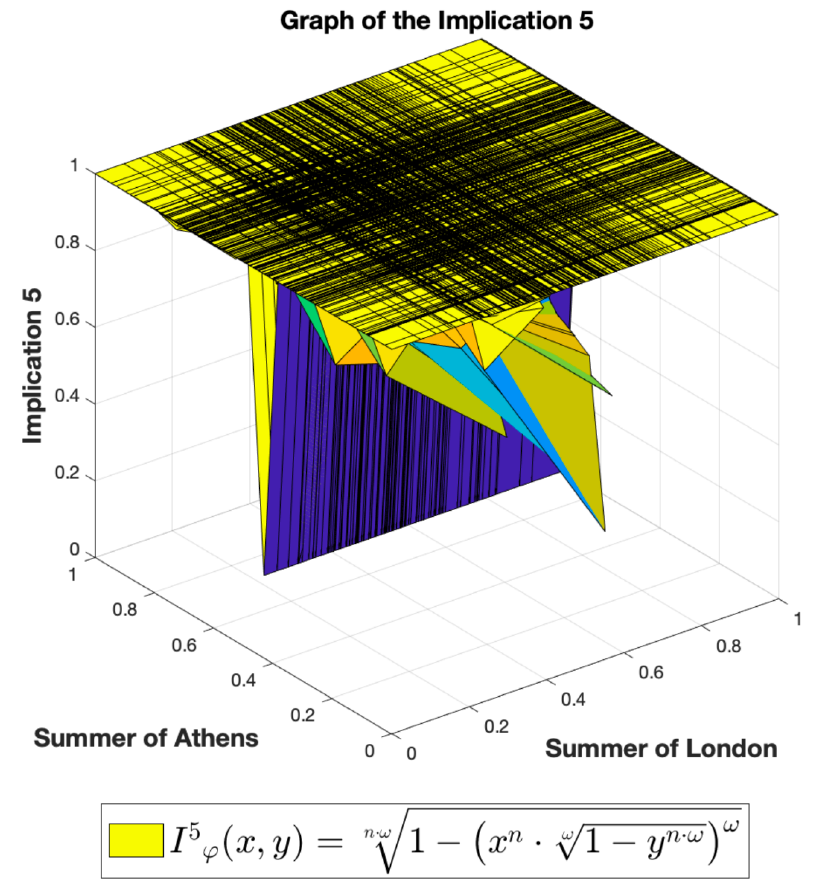
Figure 6. Graph of the Implication